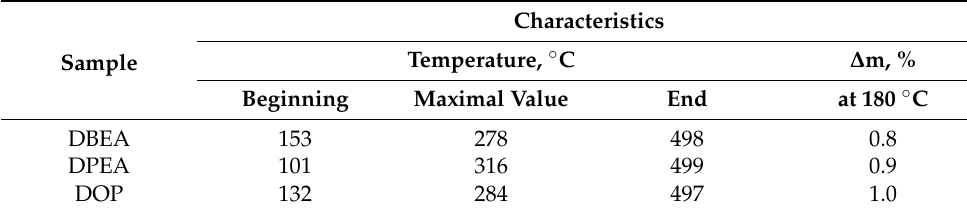
Table 2. The results of the thermal analysis of the plasticizers.